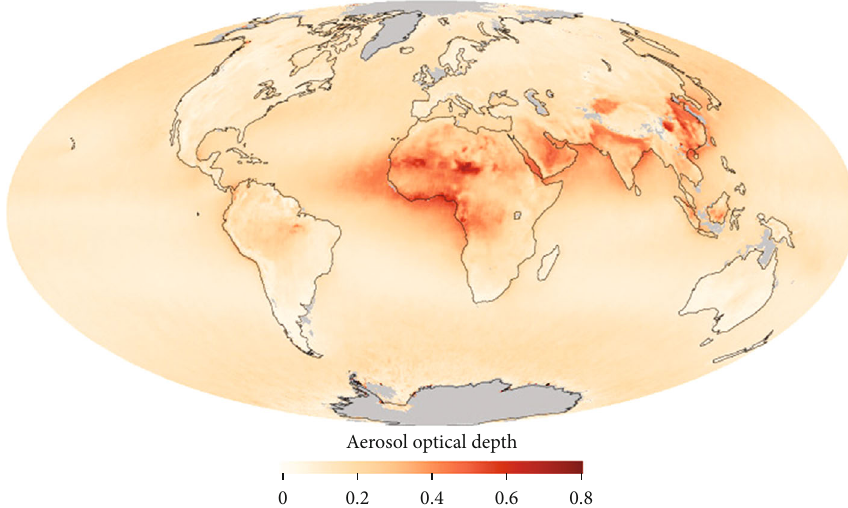
Figure 3: Global atmospheric aerosol distribution.